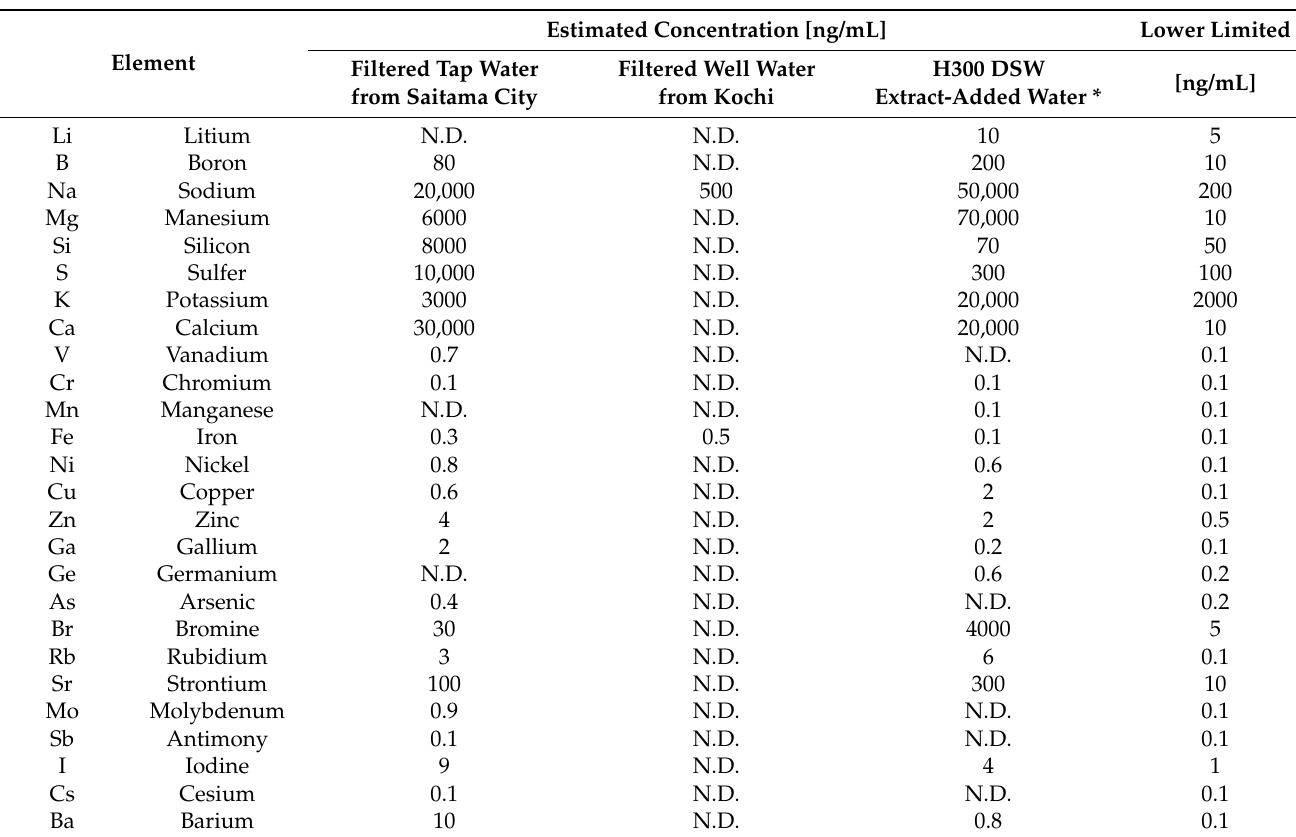
Table 2. Quantitative analysis of elements contained in each